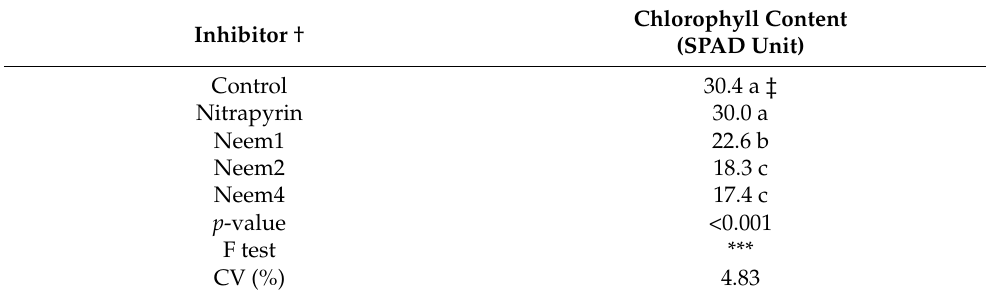
Table 8. Chlorophyll contents of lettuce leaves as affected by different nitrification inhibitors. Inhibitor †